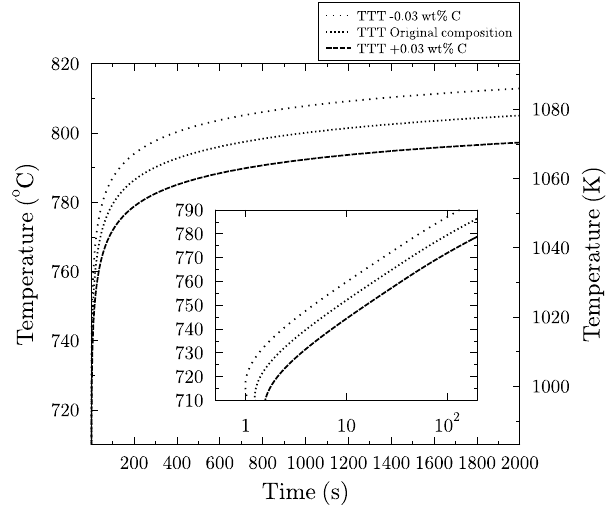
Figure 7. The start time of the original steel composition is compared to the compositions where the carbon wt % decreased/increased by 0.03%. The inset shows the change on a smaller scale near the ideal TTT “nose” in a logarithmic plot.